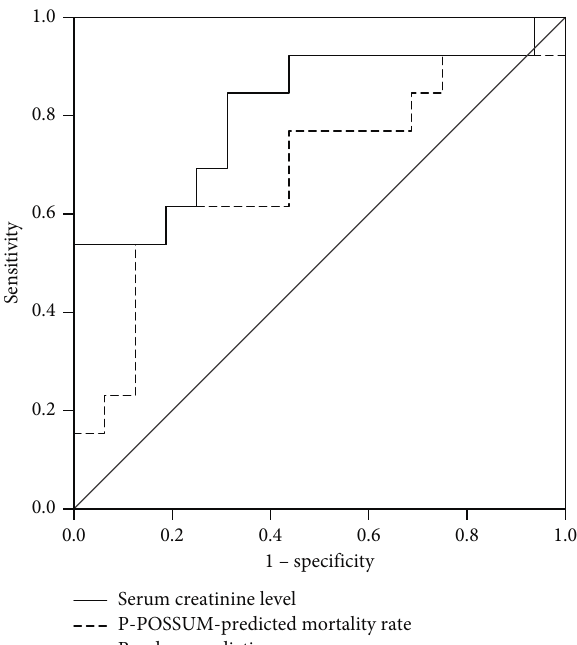
Figure 1: Receiver operating characteristic curves for the serum creatinine level (bold solid line) and the P-POSSUM-predicted mortality rate (bold dotted line). The area under the curve (AUC) of the serum creatinine level for in-hospital mortality is 0.813 (95% confidence interval [CI]: 0.646–0.979, p � 0.004) and that of P-POSSUM is 0.687 (95% CI: 0.483–0.892, p � 0.087). The optimal cutoff value of the serum creatinine level was 1.59mg/dL with a sensitivity of 0.846 and a specificity of 0.687 to predict in-hospital